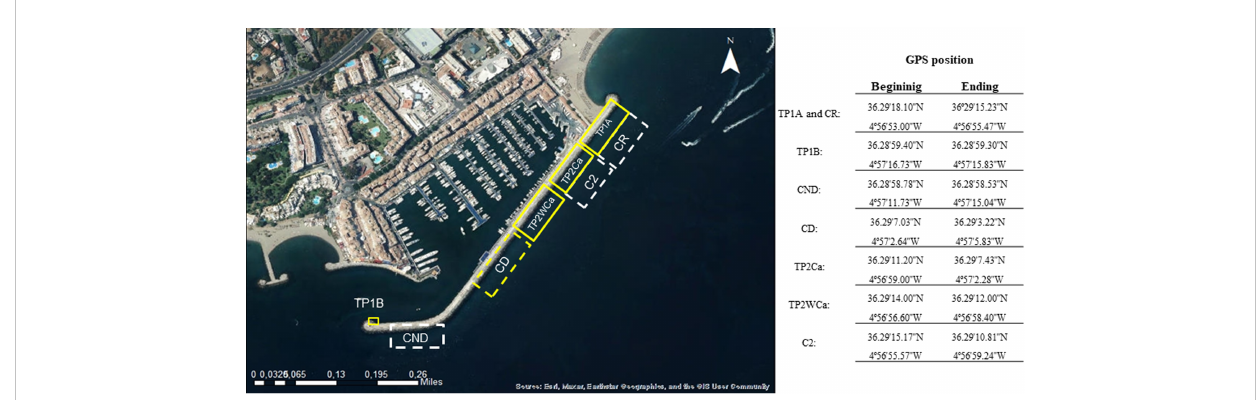
FIGURE 2 Location of receptor, control, and donor areas in PJB. TP1A and TP1B: receptor areas for limpets translocated in phases P1A and P1B of the pilot project. Receptor areas for limpets translocated in phase P2, TP2Ca: limpets relocated in fi xed metal cages; TP2WCa: limpets relocated without cages. The 4 control zones considered are delimited in dashed lines, CR, receptor control; CD, donor control; CND, non-donor control; C2, phase 2